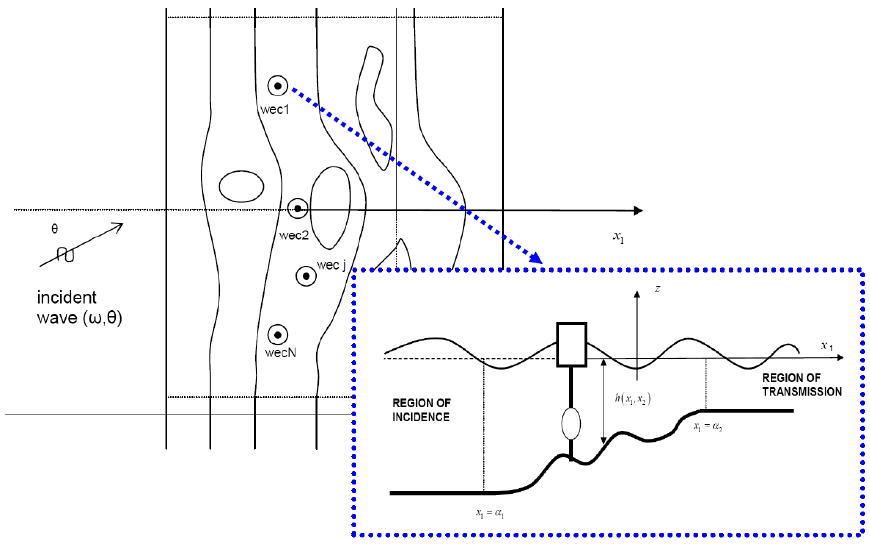
Figure 1. Array of WECs in variable bathymetry region.